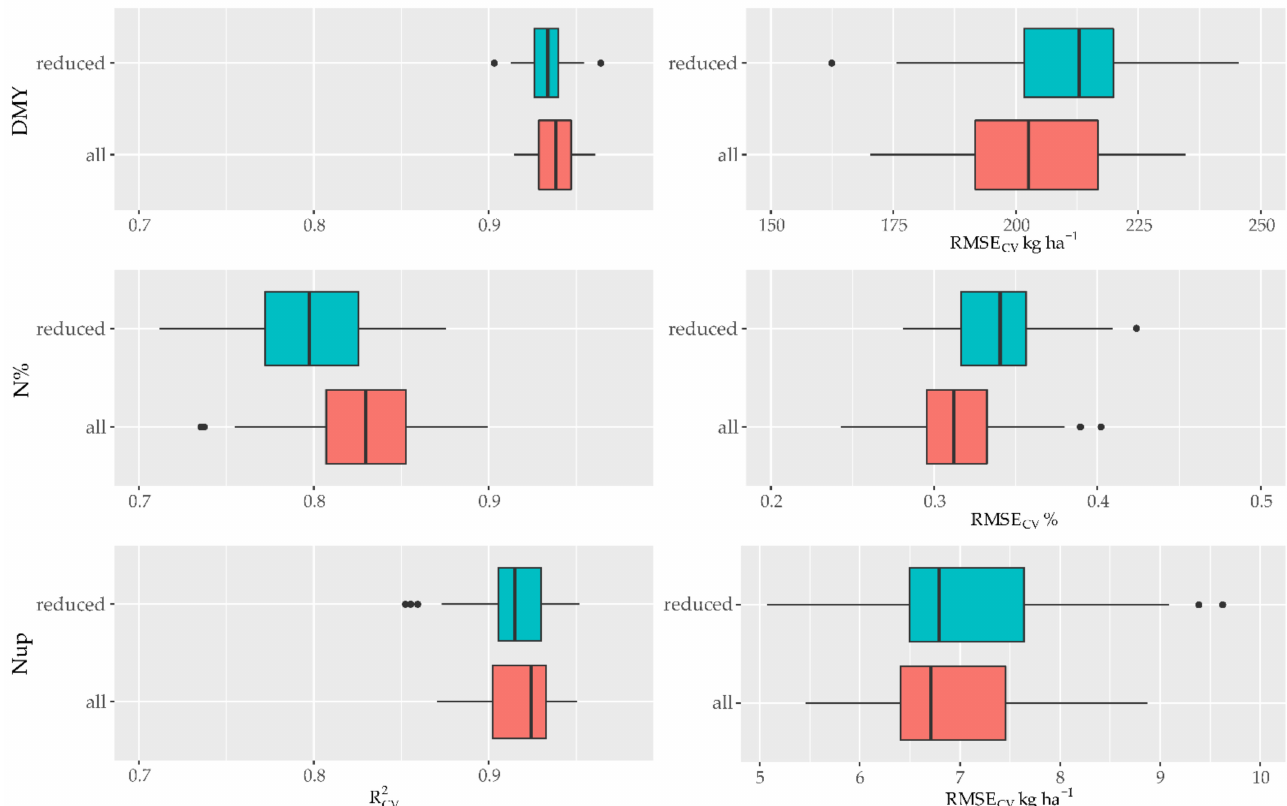
Figure 20. Box and whisker plot of RMSE CV of all resamples of the reduced feature sets and all features included (random forest) for DMY, N%, and Nup predictions. The ten best features based on variable importance of the full model are included in the reduced feature